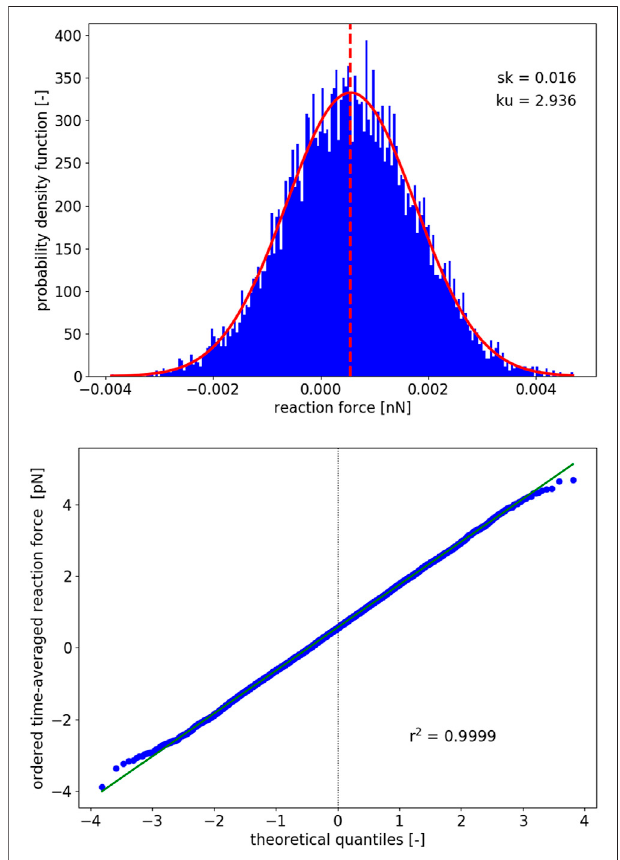
FIGURE 4 | As in Figure 3 , for the reaction force. FIGURE3| Inthe toppanel ,thehistogramofthetime-averaged friction